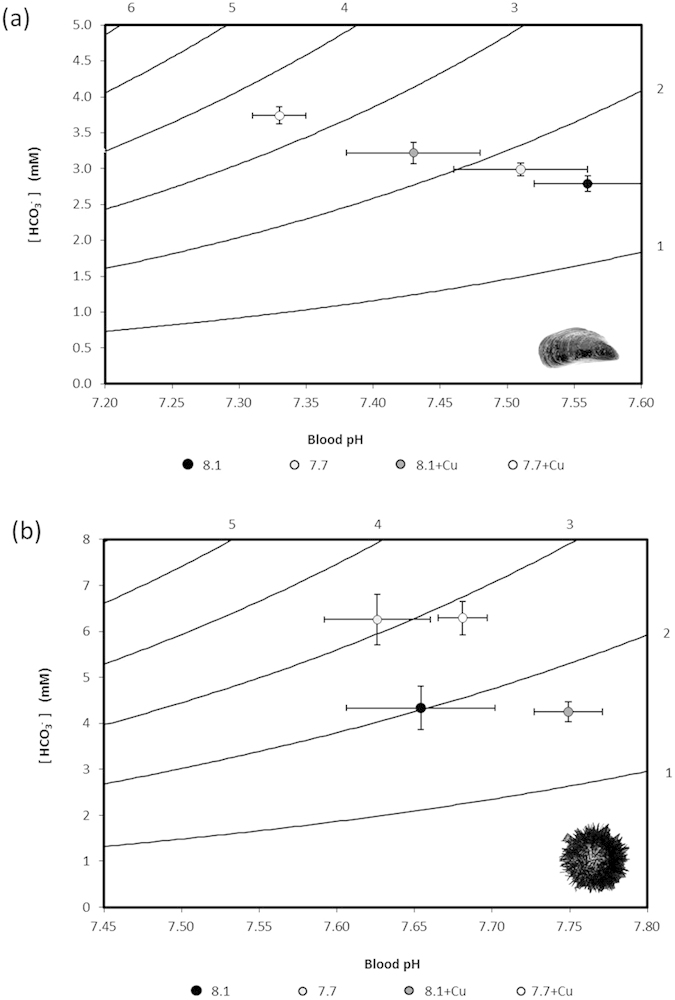
Davenport diagram illustrating the relationship between pH, bicarbonate and pCO2 in the haemolymph and coelomic fluid of (a) Mytilus edulis and (b) Paracentrotus lividus respectively. Lines represent isopleths of equal pCO2 (mmHg). Position calculated from means ± SEM for haemolymph/coelomic fluid pH and [HCO3−] according to pK1 values calculated from57.